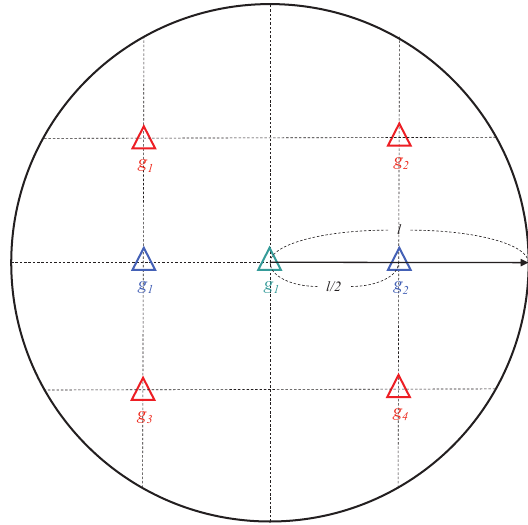
Figure 6. Deployments of gateways for network